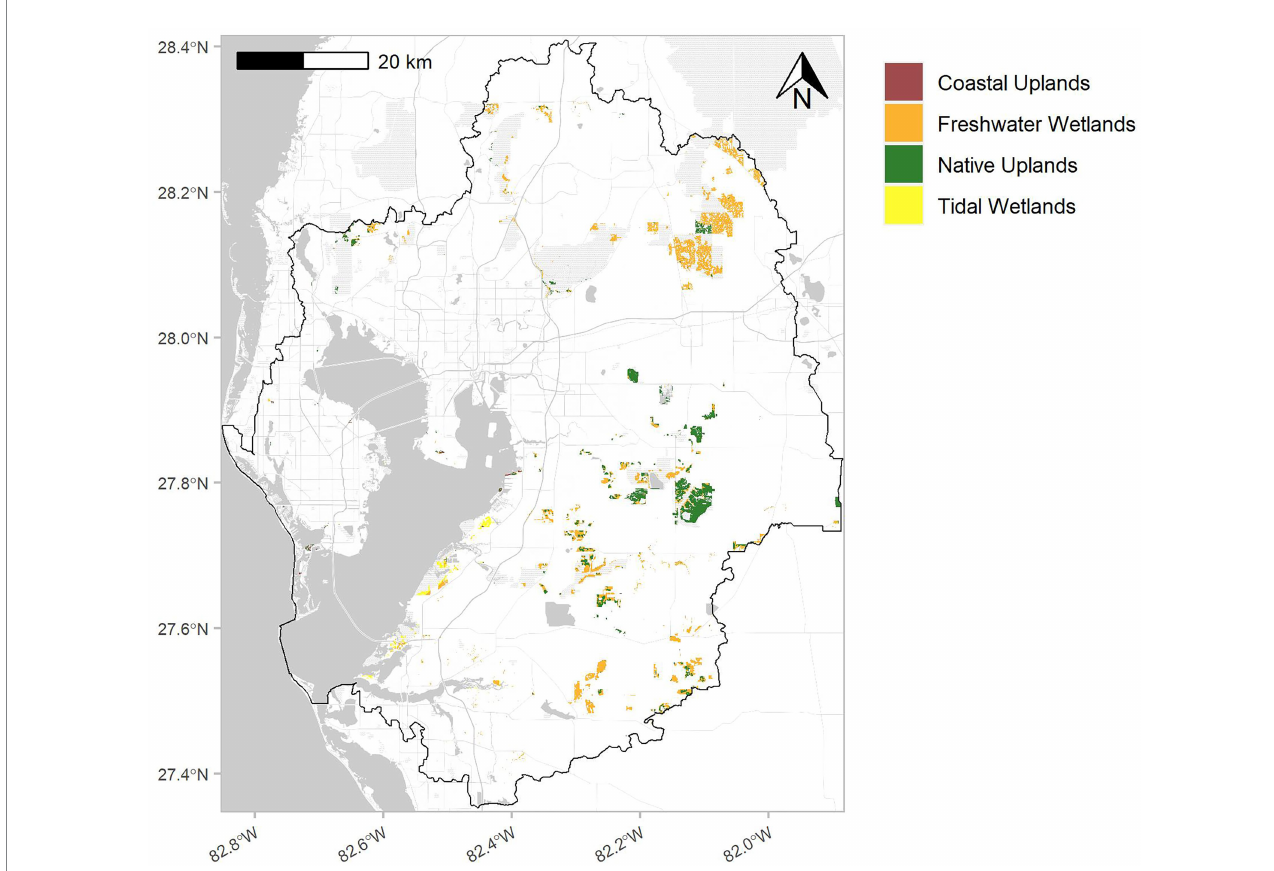
FIGURE 6 Habitat restoration potential in the Tampa Bay watershed. Areas are identified as those where habitat restoration could target the four identified categories as coastal uplands, freshwater wetlands, native uplands, or tidal wetlands. Categories are based on the opportunity areas, soil types, and coastal boundaries. The outline is the Tampa Bay